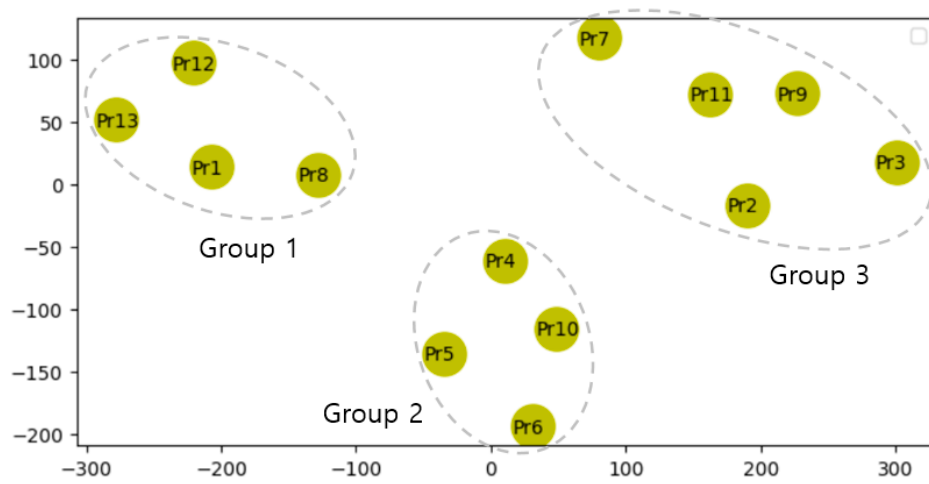
Figure 5. Correlations among AI projects (t-SNE with perplexity 5.0).